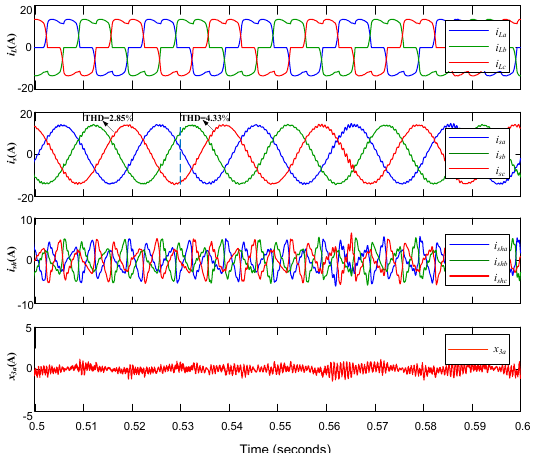
Figure 9. Simulation waveform of SAPF based on RCSMC in dynamic state.